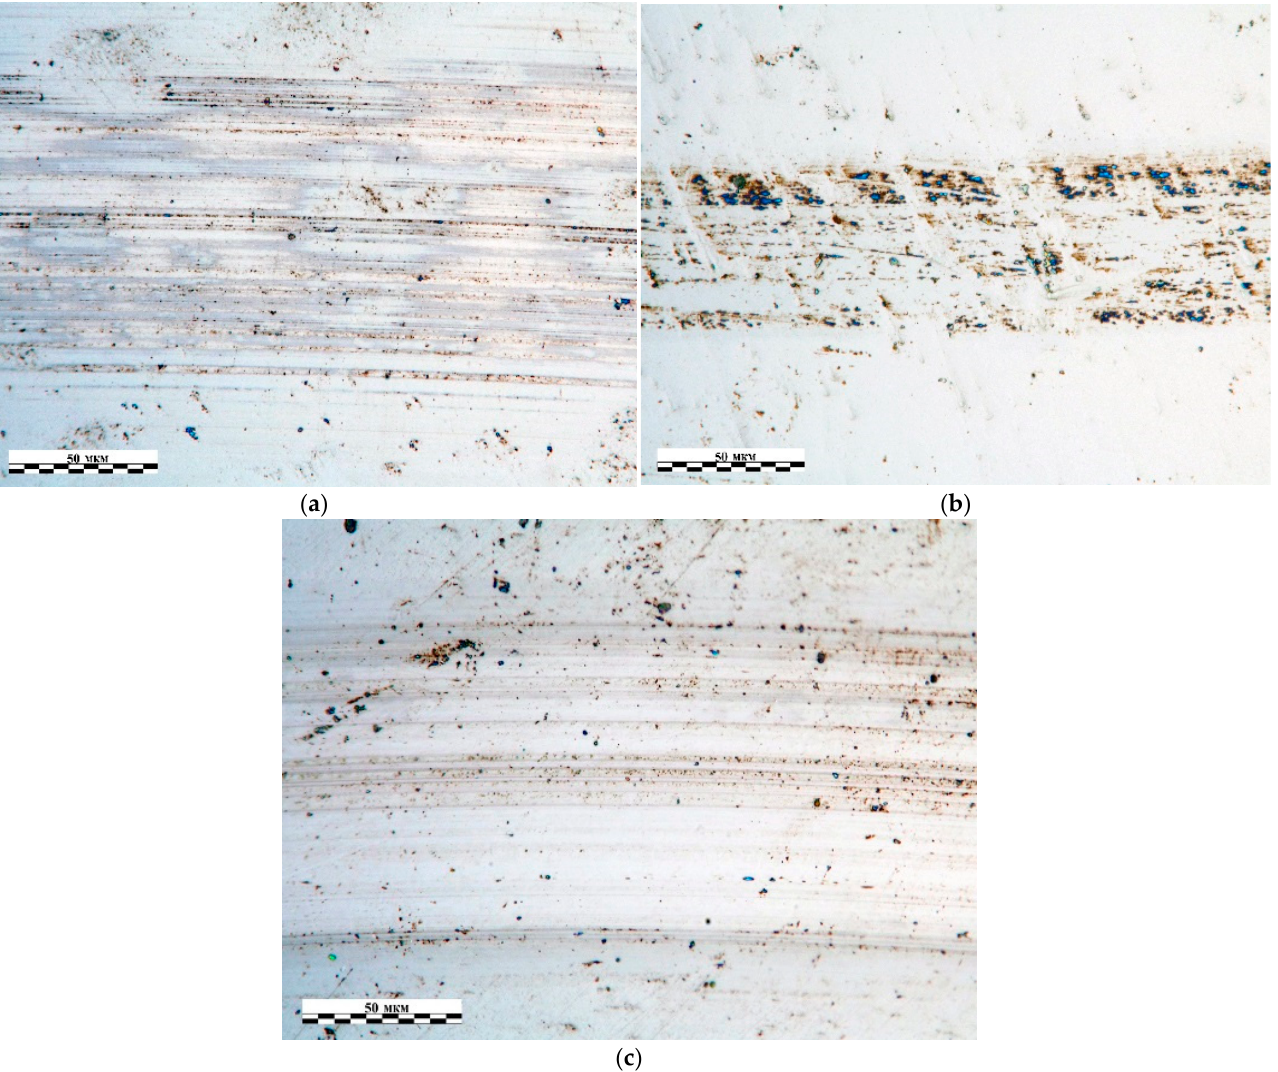
Figure 6. Optical micrographs of wear track after tribological ball-on-disk test at a normal load of 1 N and a track length of 100 m for TiCN coatings obtained at different substrate bias voltage: ( a ) 0 V, ( b ) − 70 V, ( c ) − 100 V.